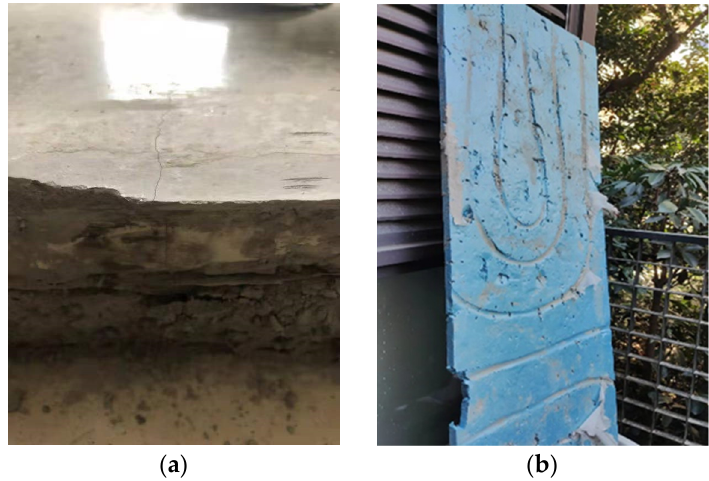
Figure 2. A case of failure of extruded plate in China. ( a ) When the strength of the leveling layer does not reach the specified strength, if the deformation of the insulation board is too large and uneven, the leveling layer is easy to crack; ( b ) due to excessive deformation of the insulation layer over time, the thickness has been reduced by 2–3 cm. This makes the insulation less functional.